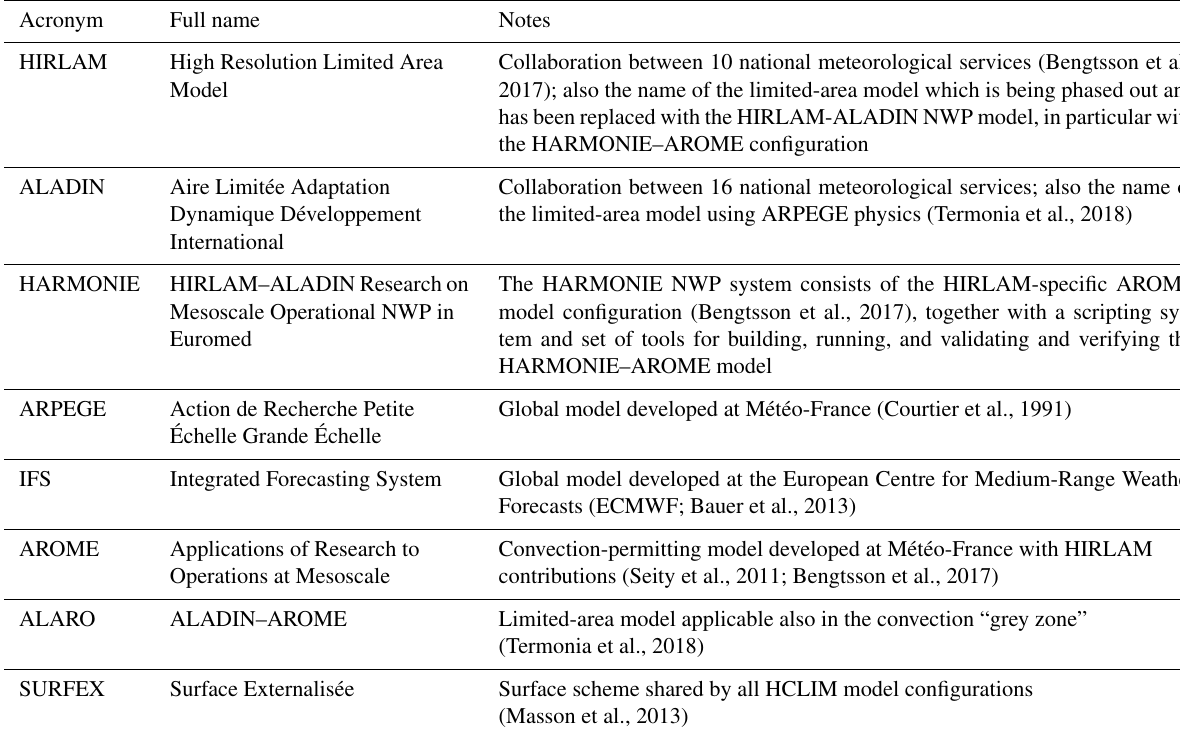
Table 1. List of main acronyms related to the HCLIM